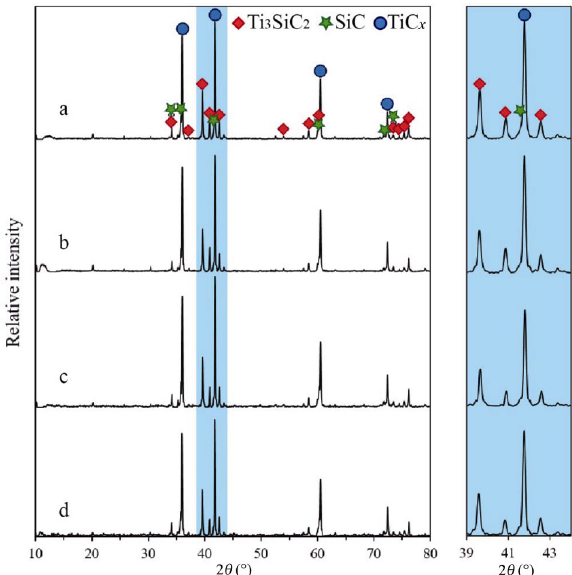
Fig. 3 XRD patterns of porous ceramics at different sintering temperature: (a) 1440 ℃ , (b) 1460 ℃ , (c) 1480 ℃ , (d) 1500 ℃